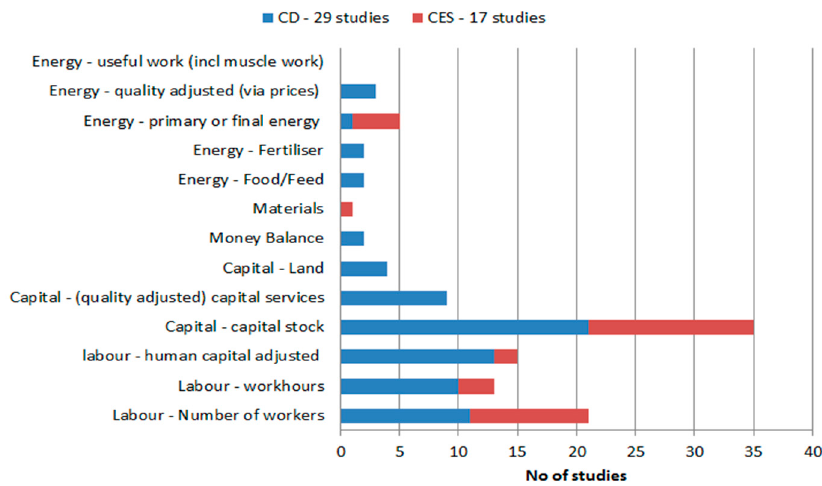
Figure 3. Factors of production in the sample.